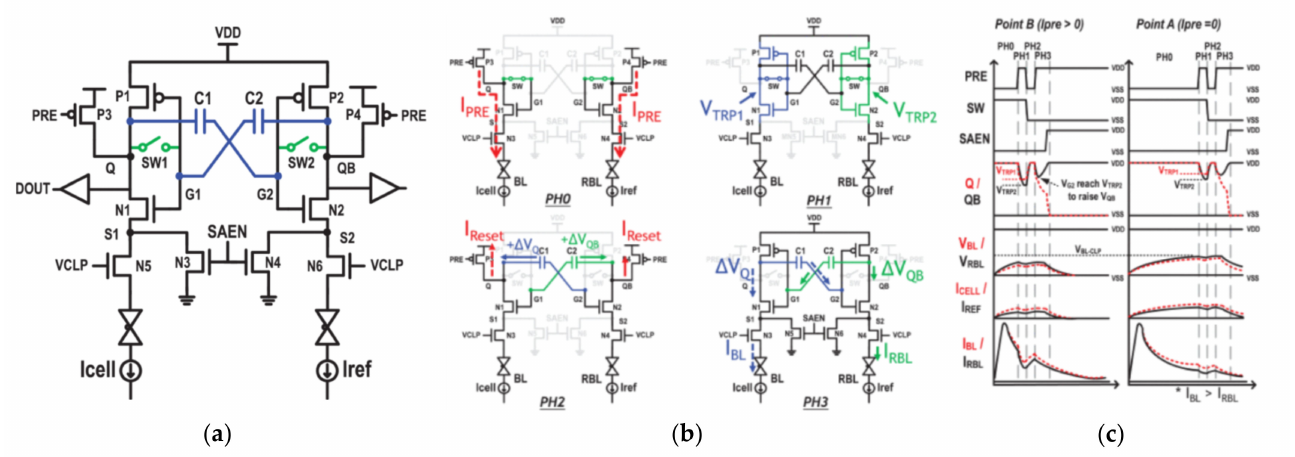
Figure 12. ( a ) The scheme of DTPMS; ( b ) the operation of DTPMS; ( c ) the simulation of DTMPS [84].